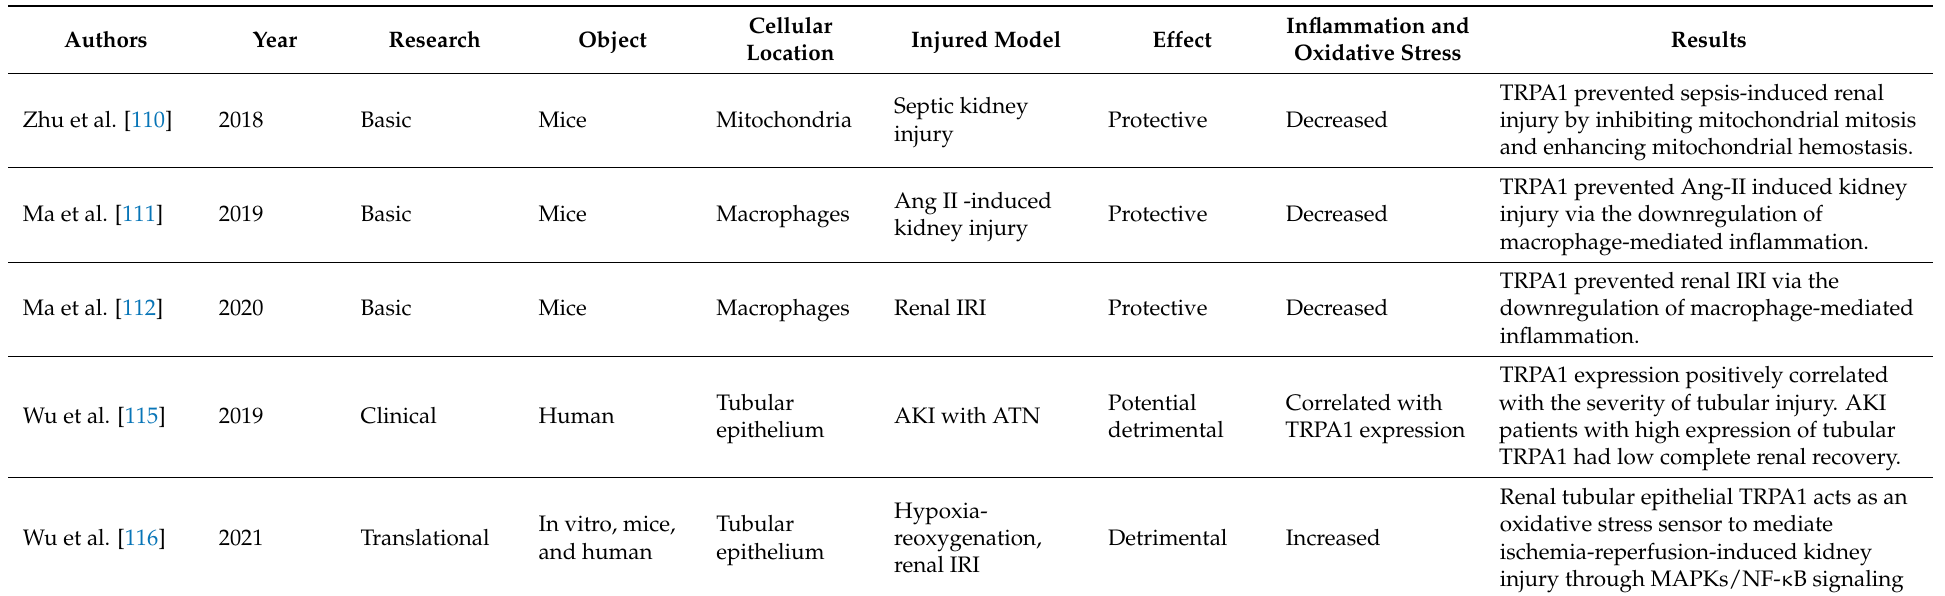
Table 1. Review of previous articles on TRPA1 in kidney